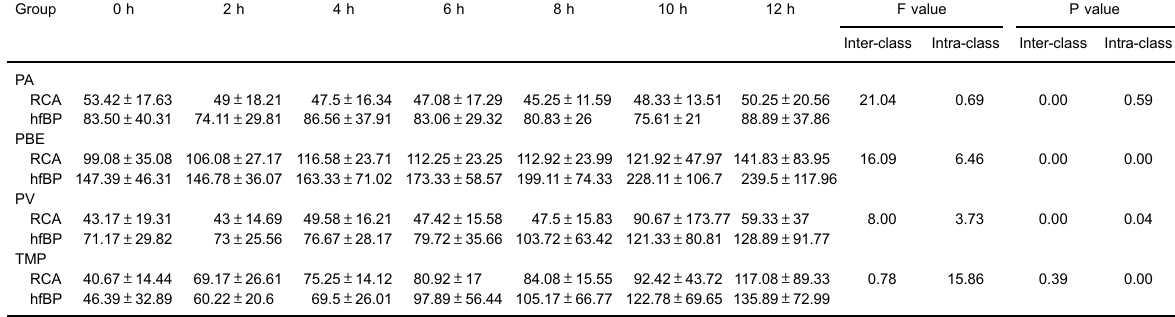
Table 3. Anticoagulation ef fi cacy of regional citrate anticoagulation (RCA) and heparin-free blood puri fi cation (hfBP) treatments. Group